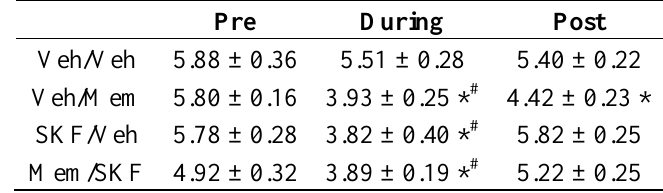
Table 4. Effects of 2.5 mg/kg SKF-38393, 0.1 mg/kg (+)-MK-801 or in combination b.i.d. for three days on daily ethanol consumption, proportion of fluids consumed and food